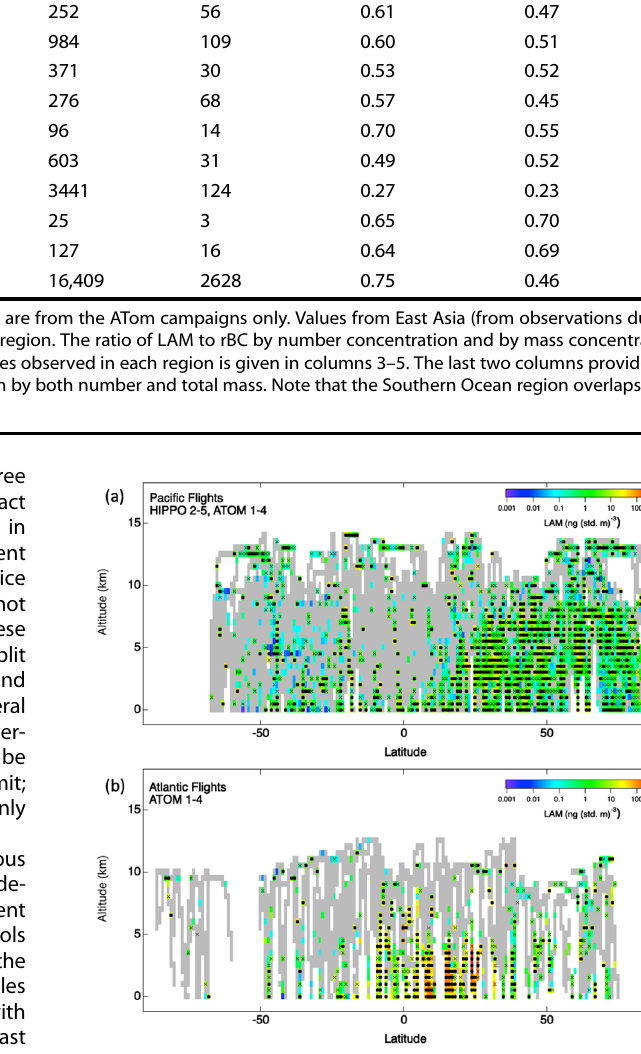
Fig. 2 Global distributions of LAM aerosols over remote Paci fi c and remote Atlantic. Observations of average LAM concentrations (ng (std. m) − 3 ) in cloud-free regions, with data gridded to a resolution of 0.5 km vertical and 1° latitude. Paci fi c (Panel a ) is de fi ned as observations in the longitude band from 150° to 225°. Atlantic (Panel b ) are observations in the longitude band from 300° to 350°. Gray indicates we sampled air, but that the average concentration of LAM was <0.001 ng (std. m) − 3 , while white indicates no data. Solid black dots indicate that observations satisfy the strong sampling criteria, while black crosses indicate observa- tions satisfy the weak sampling criteria (see “ Methods ” ). Measure- ments over the Paci fi c include observations from eight